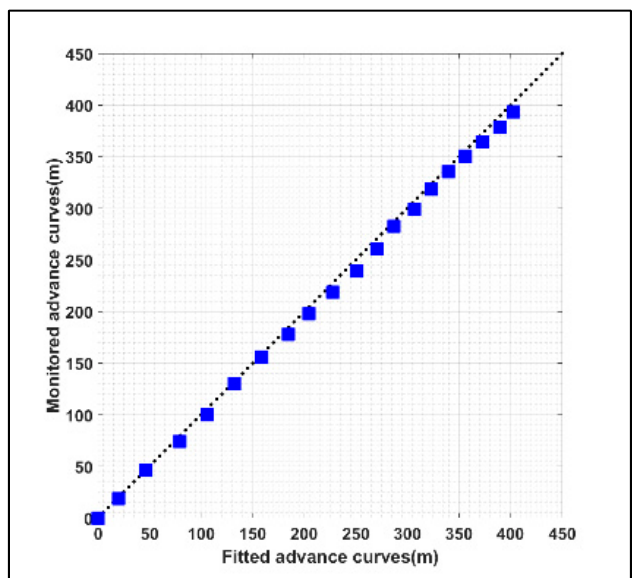
Figure 5. Comparison of measured and simulated advance curves of the surface water front for irrigation A5. The continuous line in red is the 1:1.